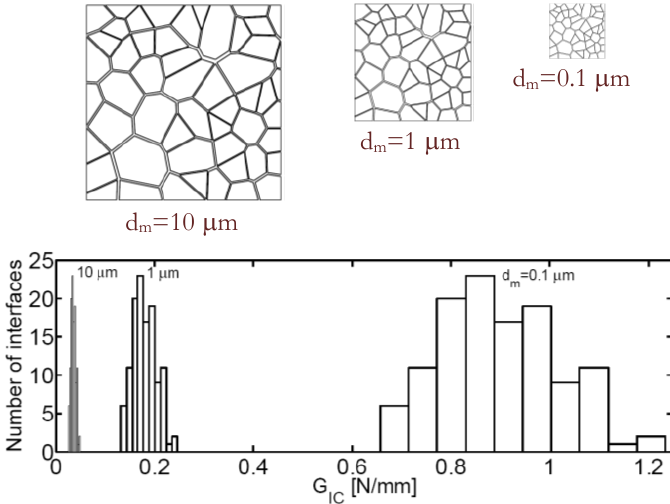
Figure 11: Distribution of interface fracture energies for three different average grain sizes.